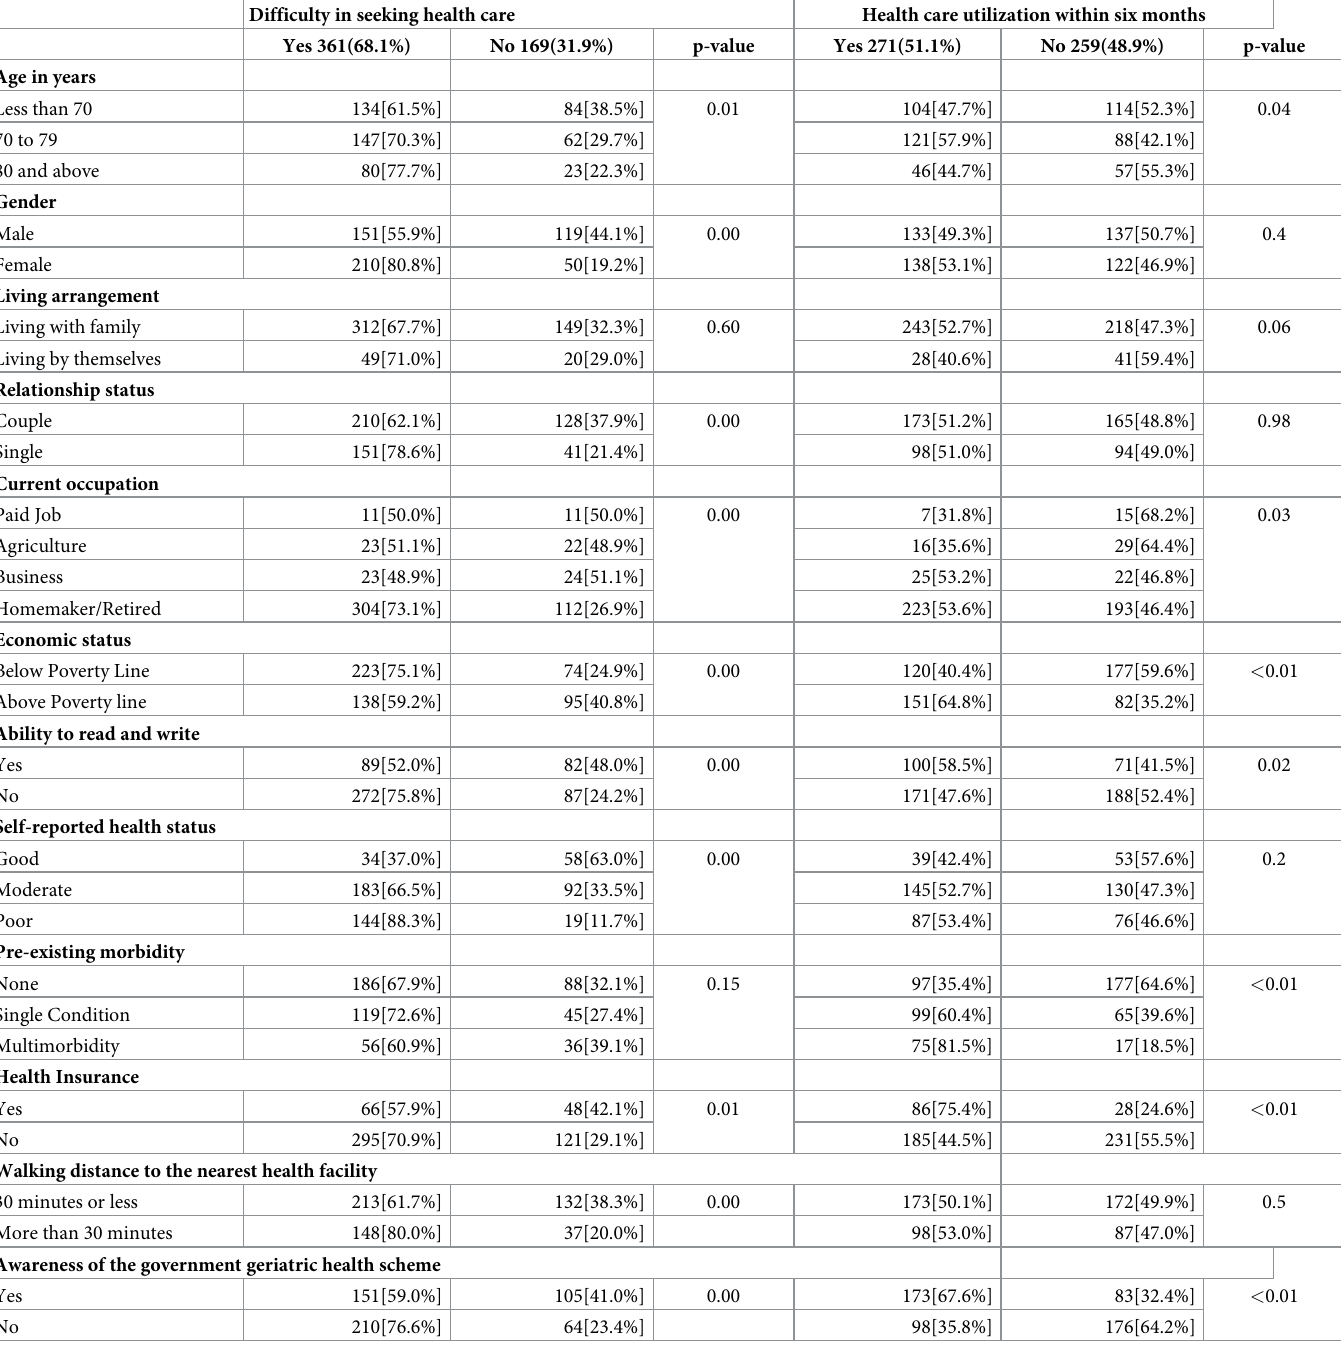
Table 4. Bivariate analysis of different variables with difficulty in seeking health care and health care utilization within six